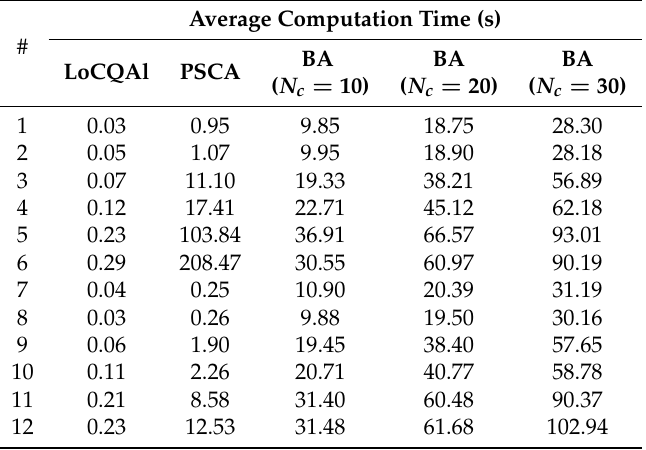
Table 8. Average computation time in the second